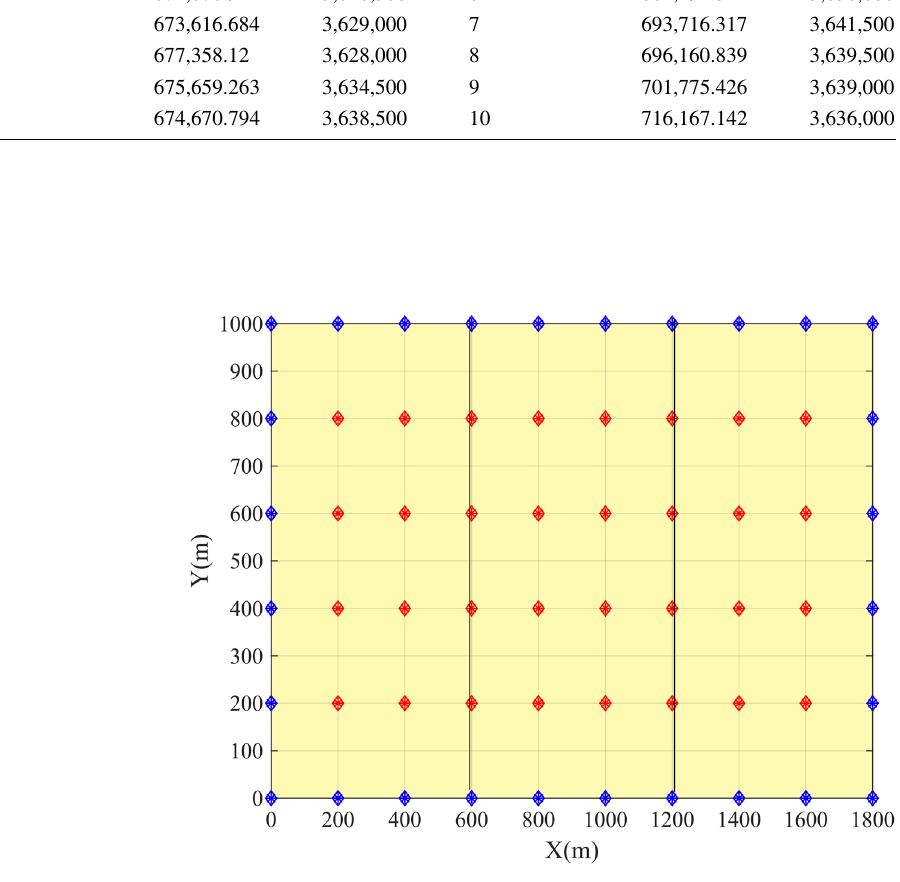
observation wells (piezometers) in Birjand aquifer (Majidi et al. 2022)